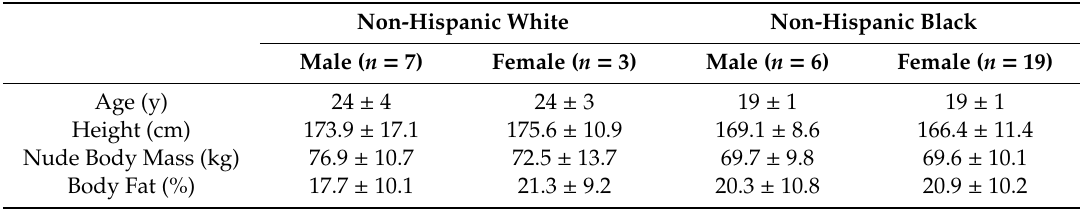
Table 1. Participant